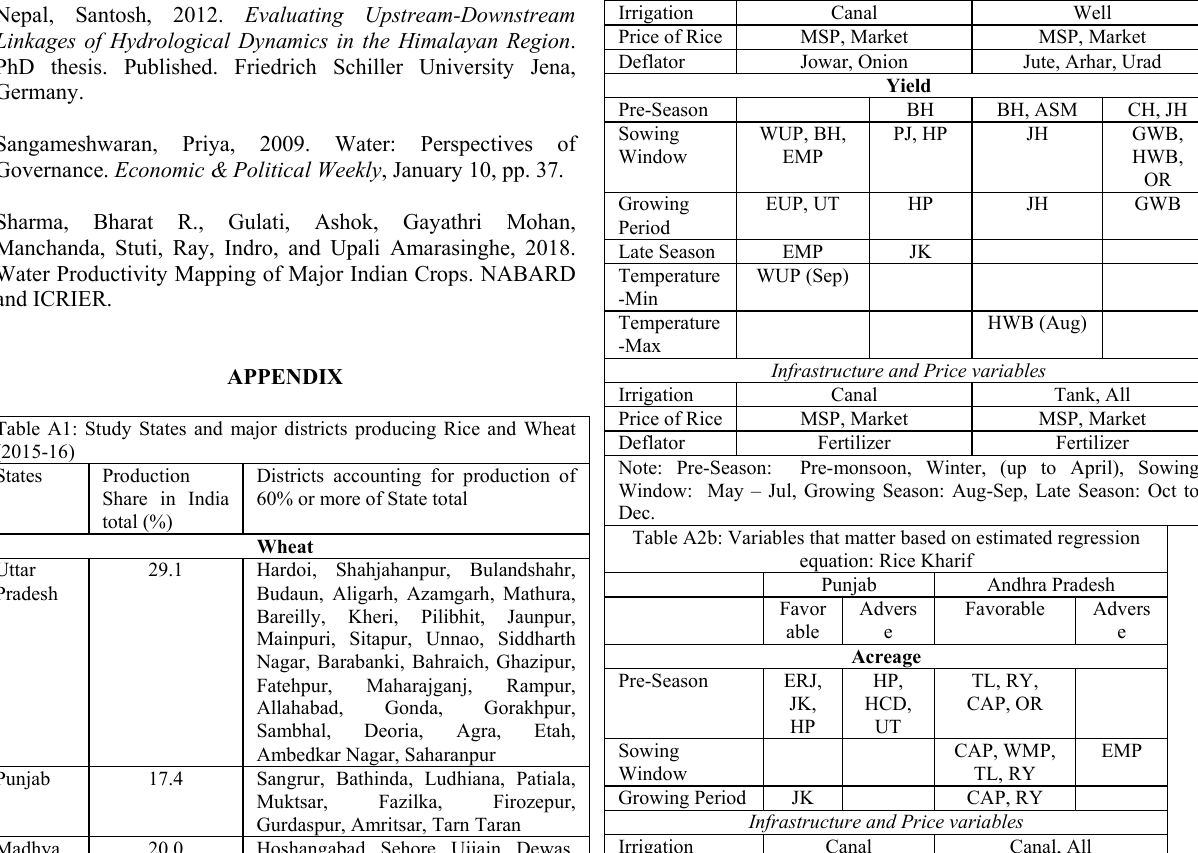
Dec. Table A2b: Variables that matter based on estimated